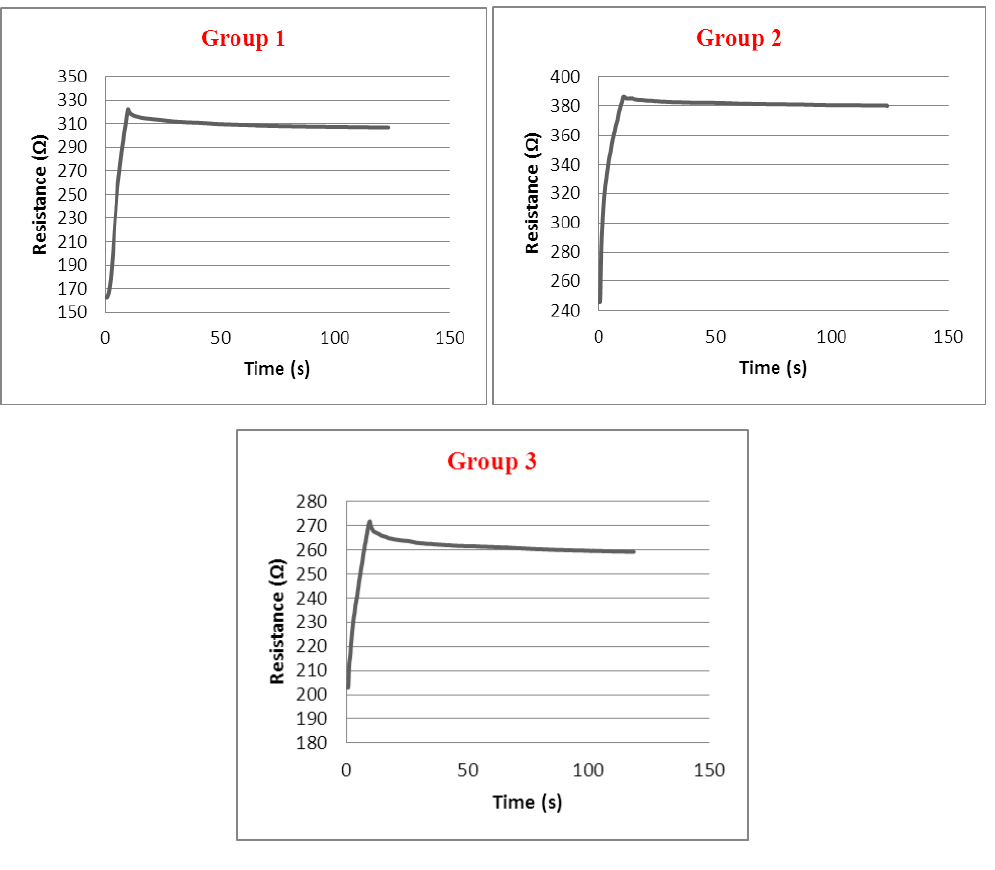
Figure 9. Relaxation behaviour of sensors at 40%